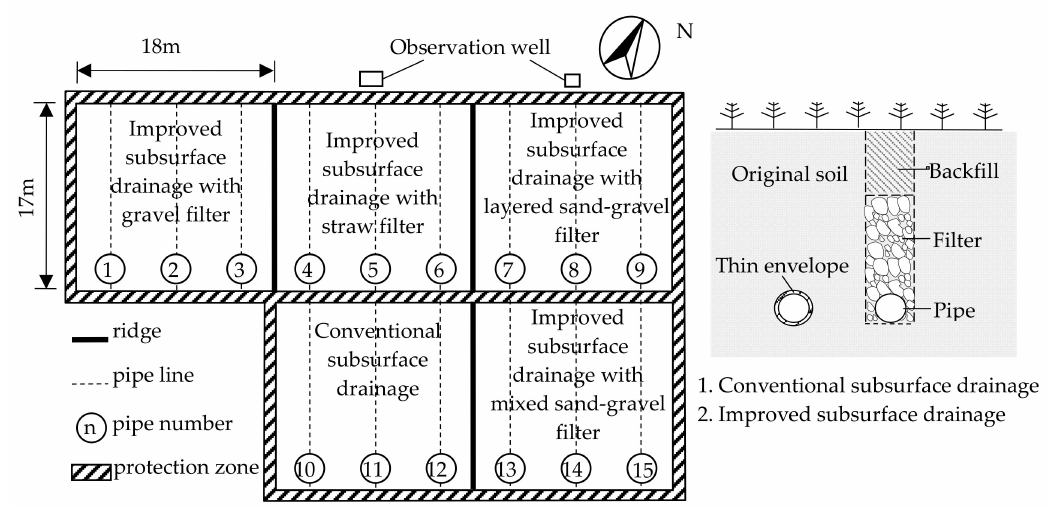
Figure 1. Layout of the field